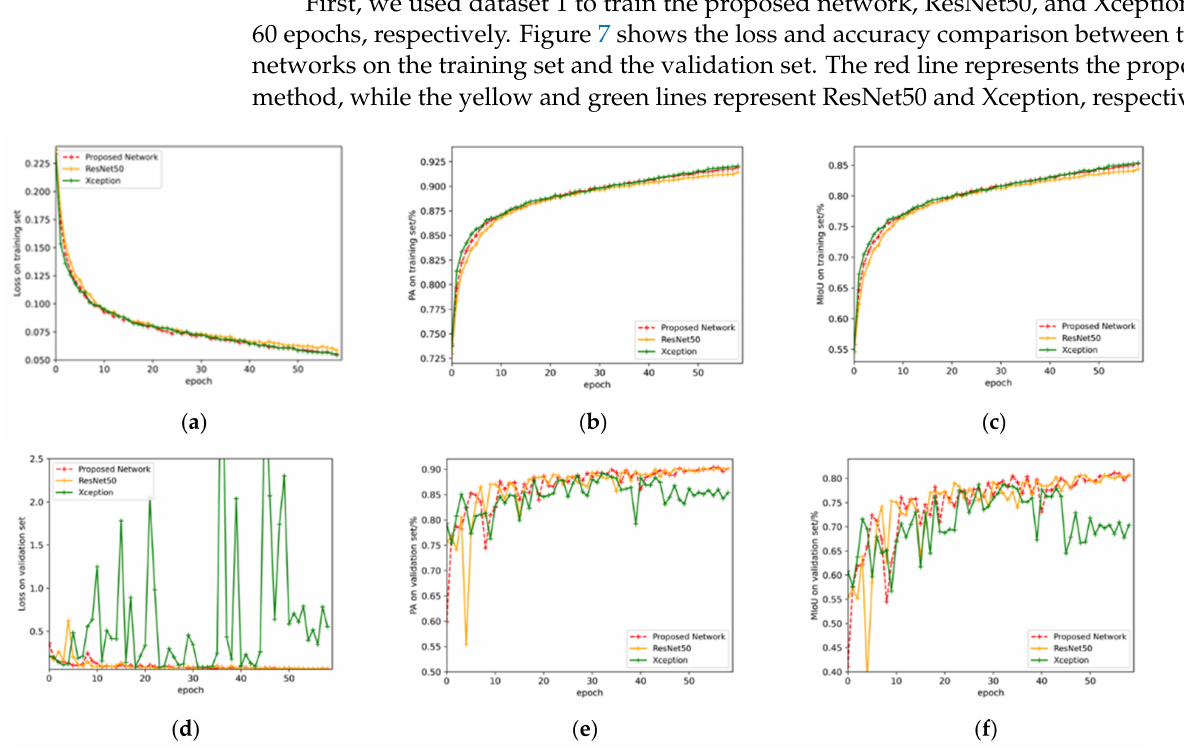
Figure 7. Results of three networks on dataset 1. ( a ) Training loss; ( b ) training PA; ( c ) training MIoU; ( d ) validation loss; ( e ) validation PA; ( f ) validation